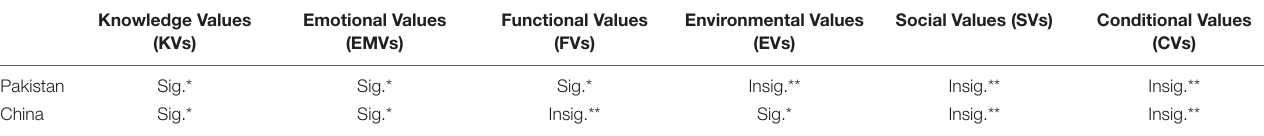
TABLE 11 | Comparison of variables between Pakistan and